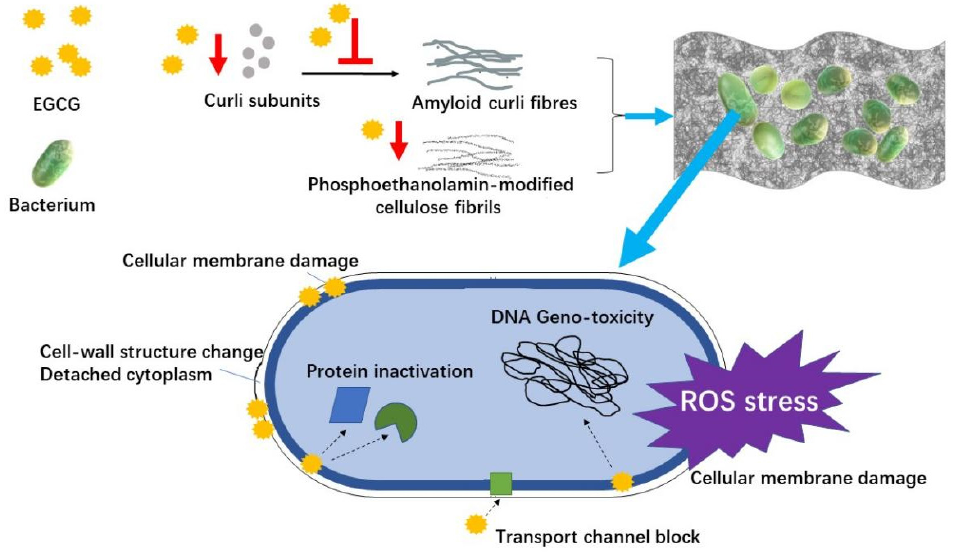
Figure 2. The antimicrobial mechanism of EGCG in skin wound healing process.